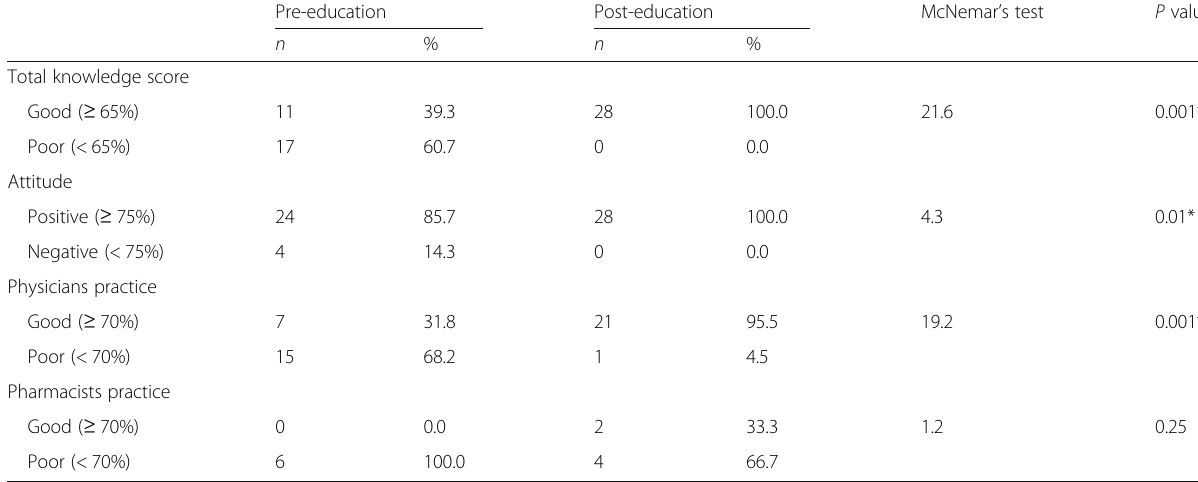
Table 1 Total knowledge, attitude, and practice score of respondents ’ physicians and pharmacists regarding antimicrobial stewardship program before and after the educational program